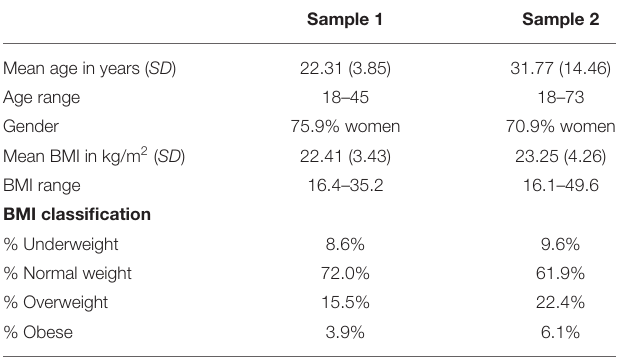
TABLE 1 | Study samples